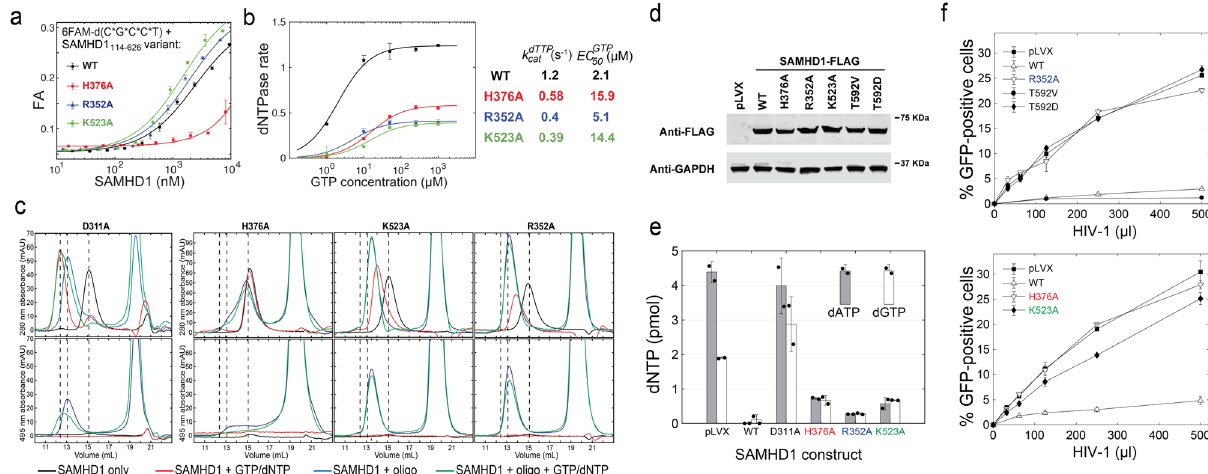
Fig. 6 Functional effects of H376A, R352A, and K523A mutations. a Oligonucleotide-binding af fi nities of allosteric site mutants measured using the fl uorescence anisotropy-binding assay ( n = 2 independent experiments). b In vitro dNTPase activities of allosteric site mutants ( n = 2 independent experiments). c Oligonucleotide binding and oligomerization properties of allosteric site mutants as monitored by SEC. d Expression of SAMHD1 variants in U937 cells. e dNTP depletion in U937 cells by WT and mutant SAMHD1 variants ( n = 2 independent experiments). f HIV-1 restriction activity of WT and mutant SAMHD1 variants ( n = 2 independent experiments). Error bars represent s.d. of two replicate measurements performed on distinct samples. Source data are provided as a Source Data